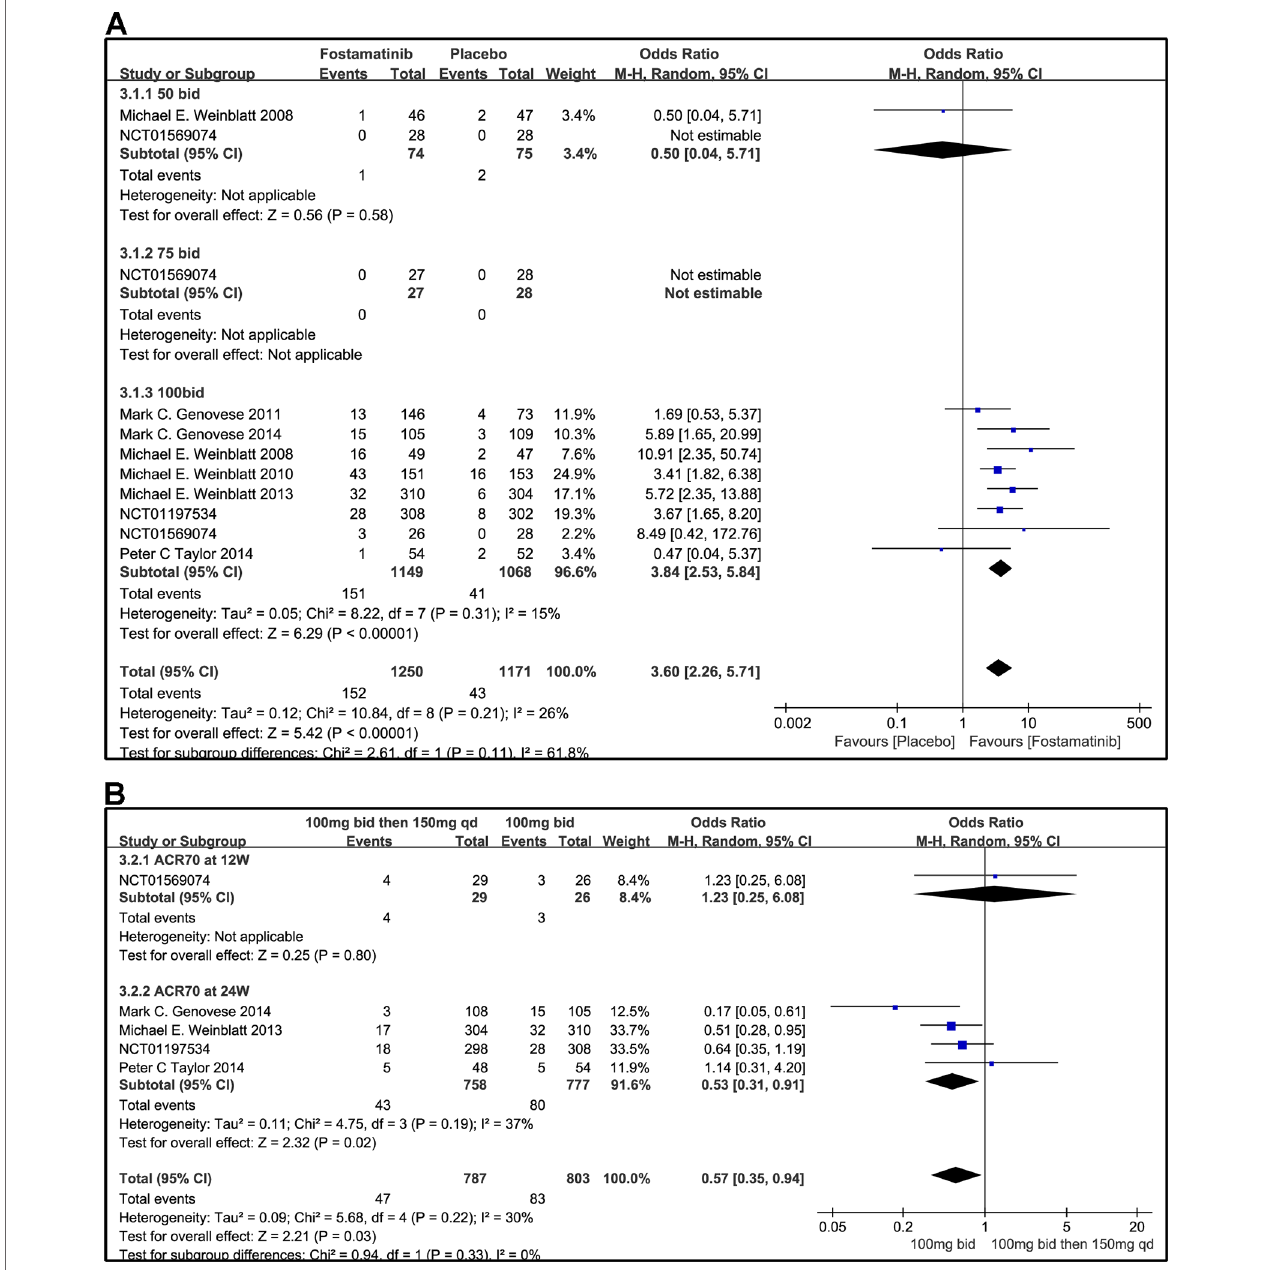
FIGURE 5 | Forest plots for the effect of multiple doses on ACR70 at different time points. (A) Subgroups administered multiple doses of fostamatinib vs. placebo at 24 weeks from baseline; (B) 100 mg bid for 4 weeks followed by 150 mg bid vs. 100 mg bid at 12 and 24